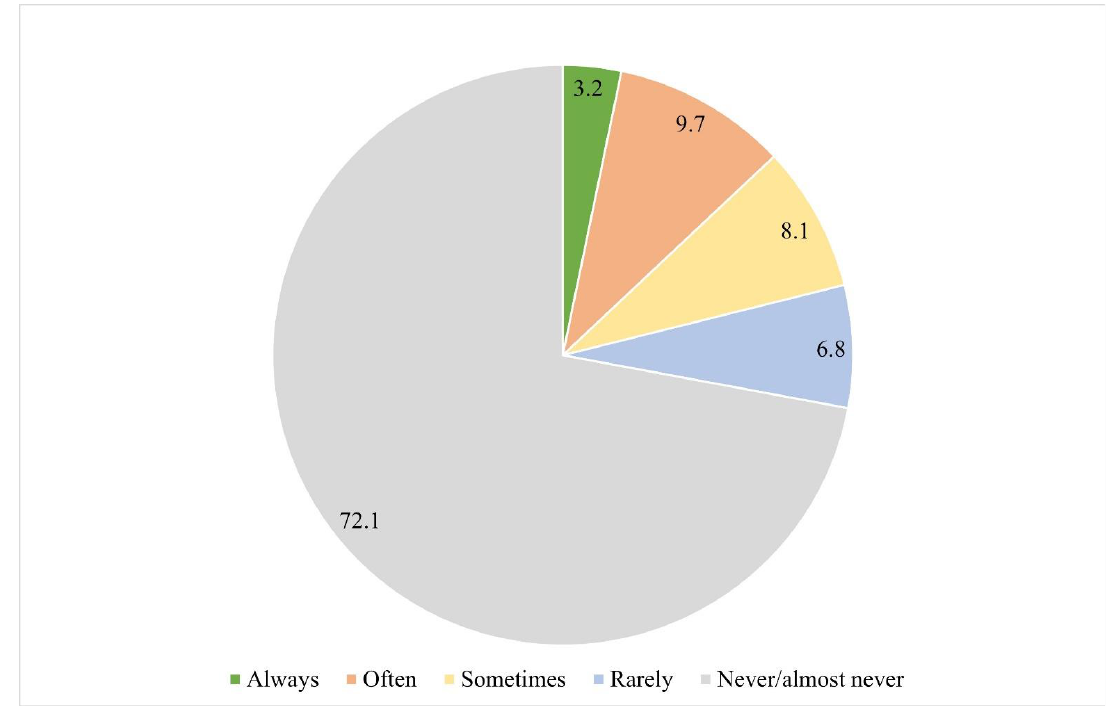
Figure A7. Use of GDPR-compliant Messenger Services. Int. J. Environ. Res. Public Health 2022 , 19 , x FOR PEER REVIEW